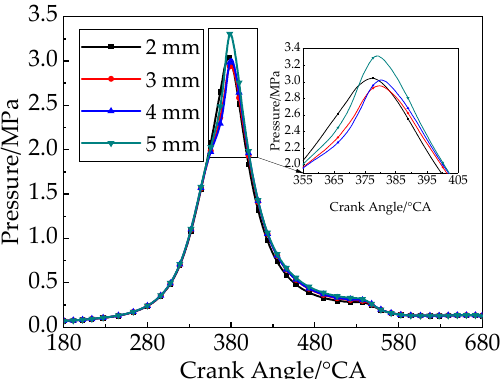
Figure 4. In-cylinder mean pressure under different grid sizes.